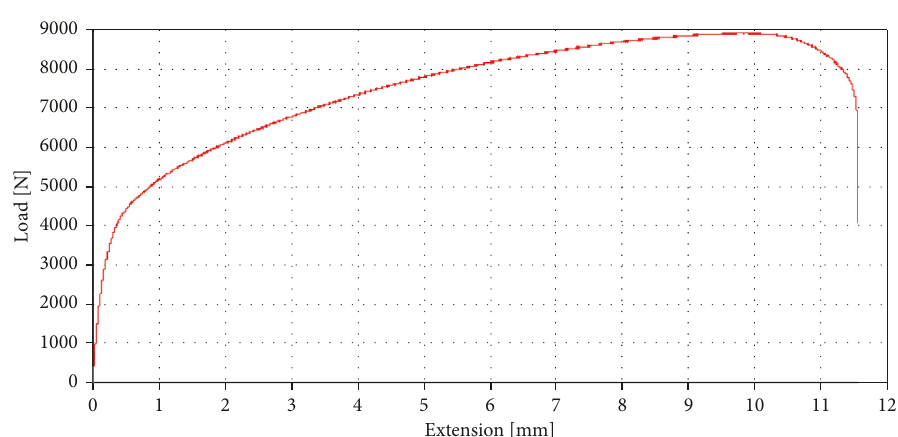
Figure 9: Stress-strain graph for the